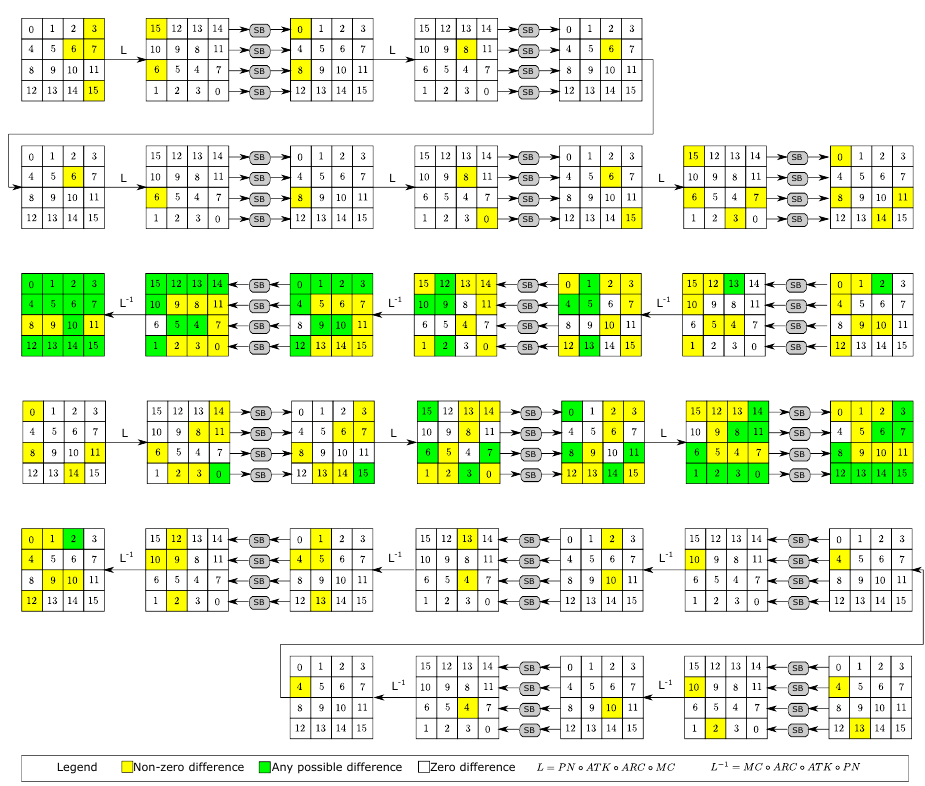
Figure 12: A Boomerang Distinguisher for 9/10 rounds of